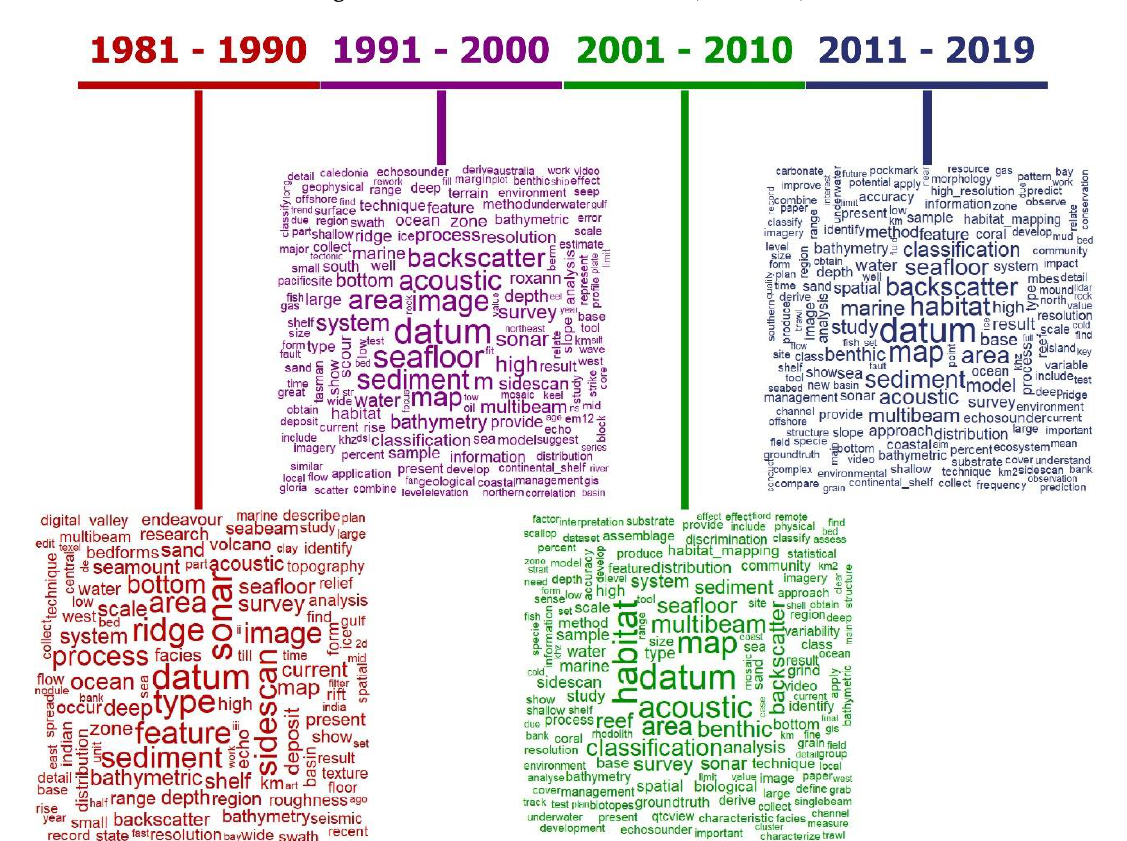
Figure 4. Word cloud for each decade (1981–2019).